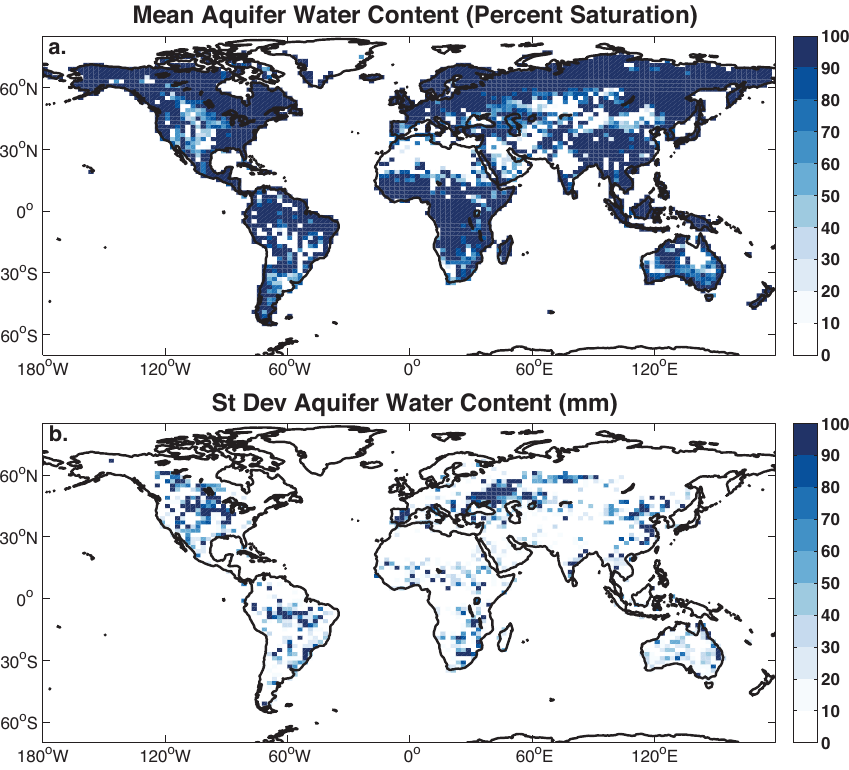
Fig. 1. (a) Mean aquifer water content (expressed as fraction of capacity) in the Aquifer run. (b) Standard deviation (mm) of monthly mean aquifer water content in the Aquifer